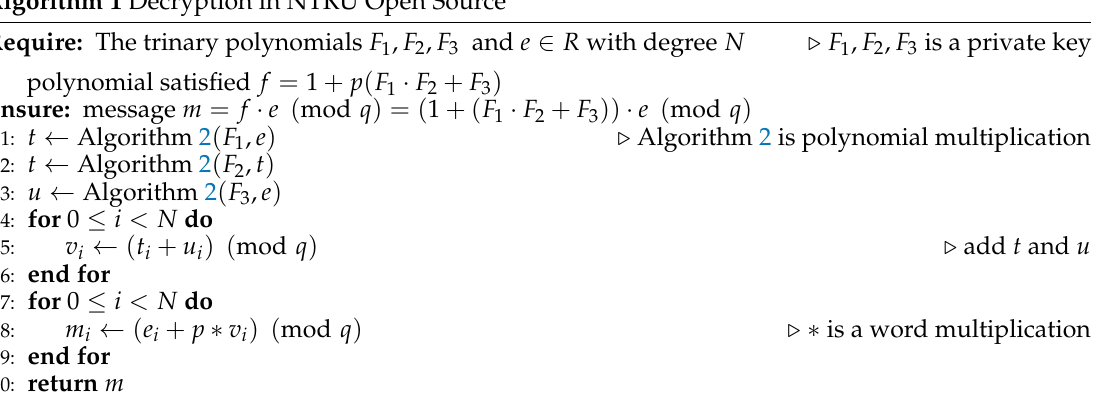
Algorithm 1 Decryption in NTRU Open